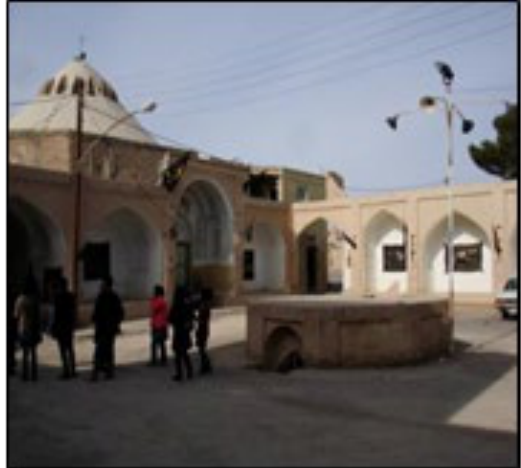
Fig. 12: Organic design of open spaces of passages